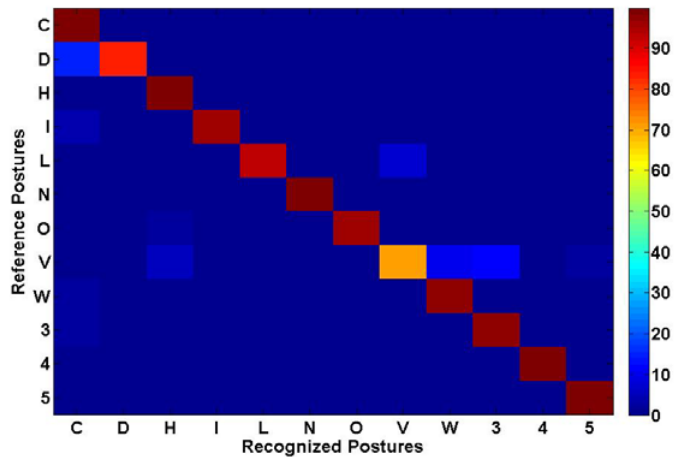
Figure 17. Confusion